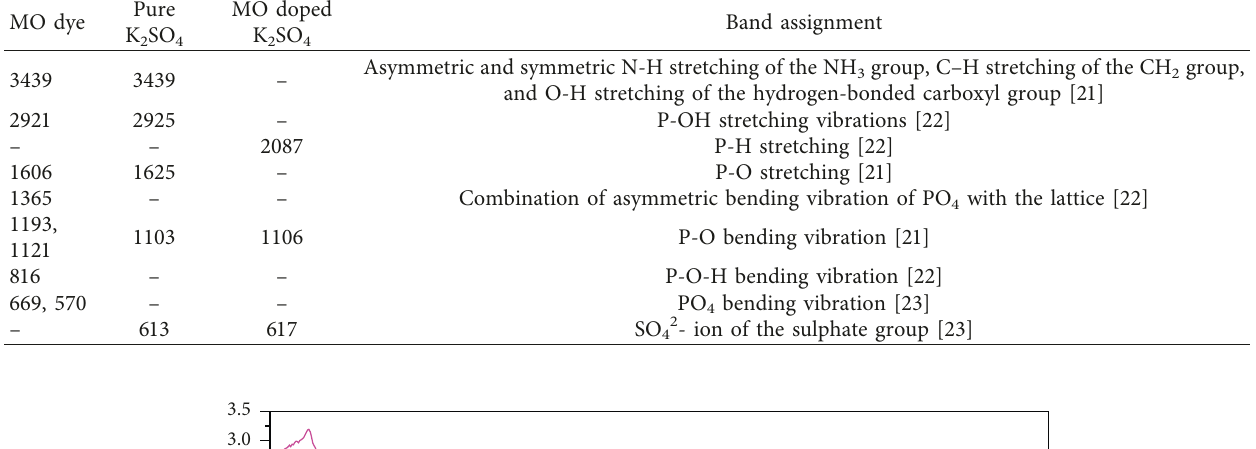
Table 1: FTIR band assignment of methyl orange (MO) dye-doped K